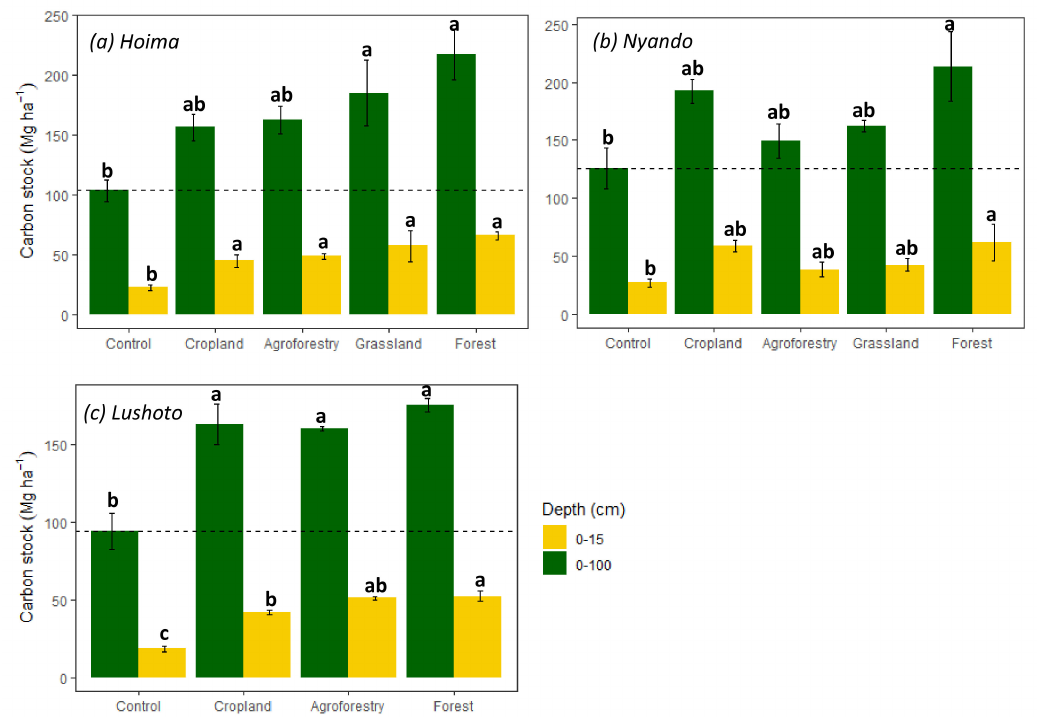
Figure 3. Total organic carbon stocks of the surface soil (0–15 cm) (yellow) and throughout the soil profile (0–100 cm) (green). Cropland, agroforestry, grassland, forest, and control land uses. Error bars show standard error of the mean. Di ff erent letters across the sampling depths indicate significant di ff erences between the means of carbon stock at p <